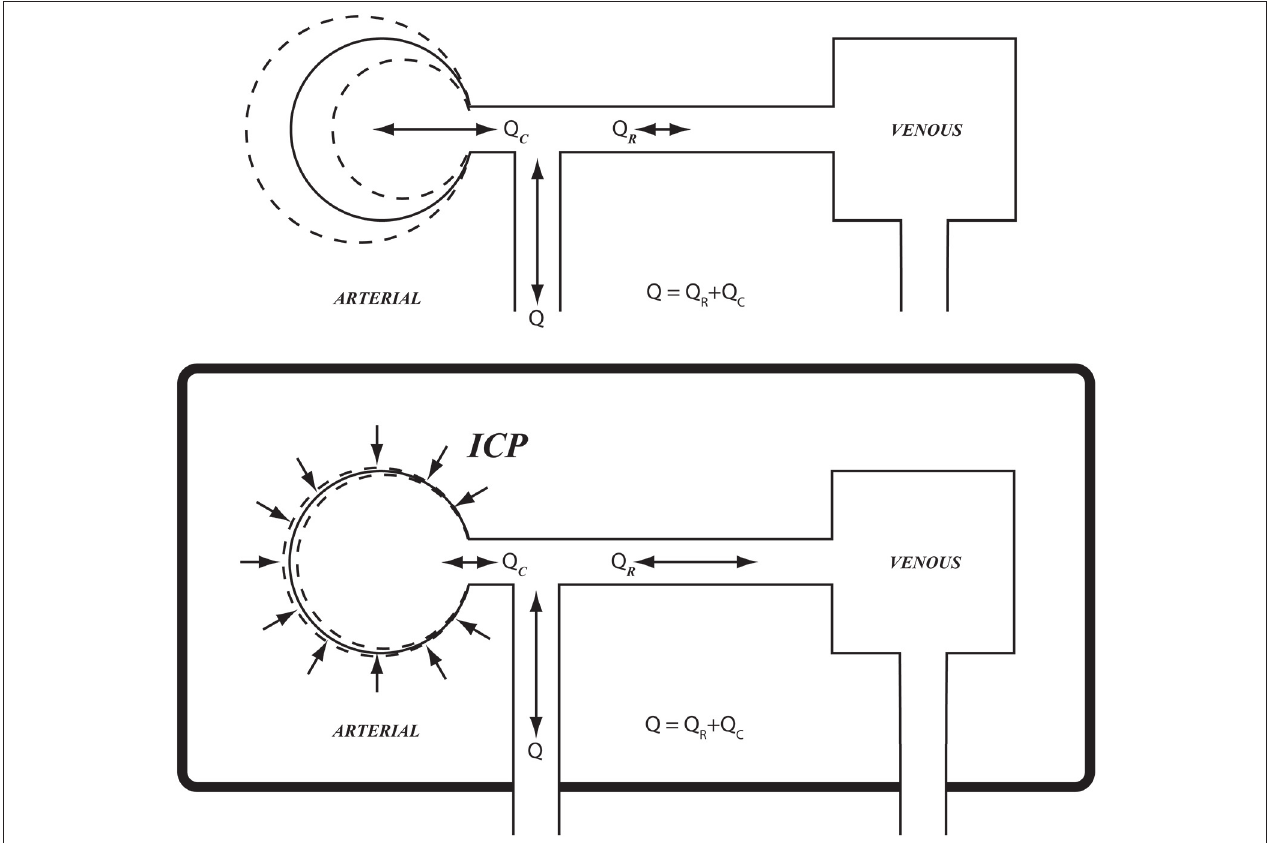
FIGURE 1 | Schematic illustration of arterial compliance as it is constrained within the confines of the rigid skull (Bottom) , compared with arterial compliance in the vascular bed of the forearm where it is relatively free from such constraint (Top) . ICP , intracranial pressure; Q , total flow rate going into the cerebral circulation; Q R , Q C , resistive and capacitive components of flow rate,